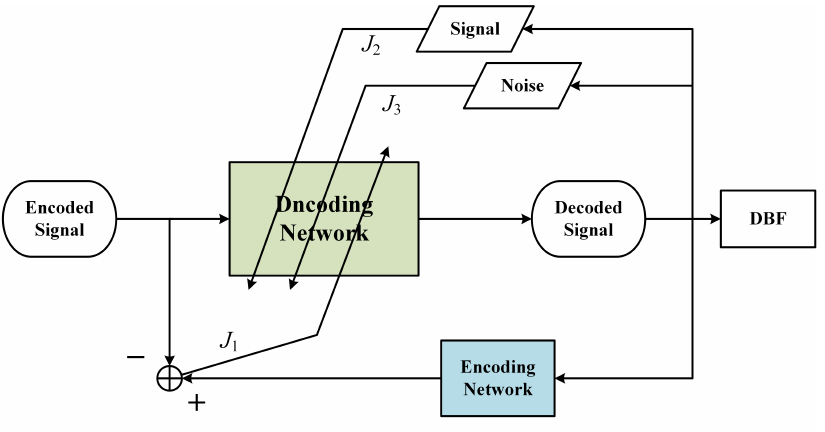
Figure 4. The training of decoding